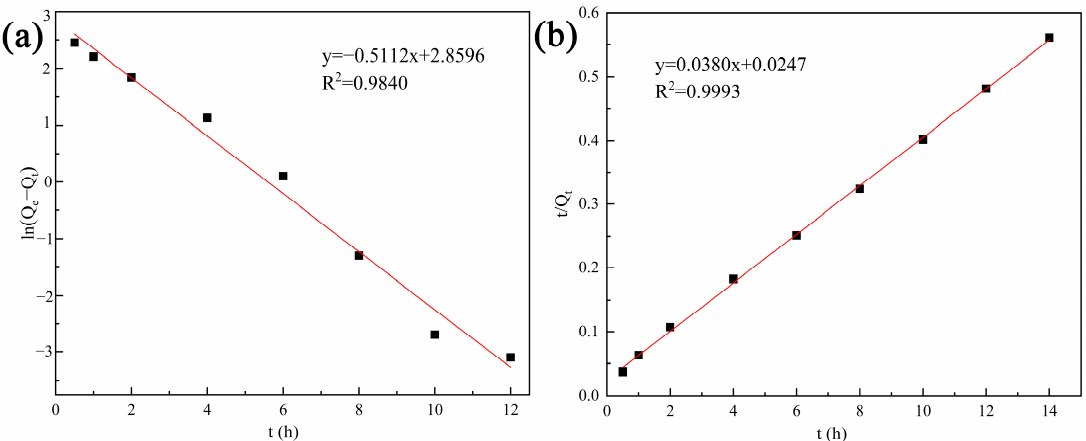
Figure 6. Kinetic models for Cd 2+ removal using tobermorite: ( a ) the PFO model and ( b ) the PSO model. Table 1. Kinetic model parameters for Cd 2+ removal using tobermorite.